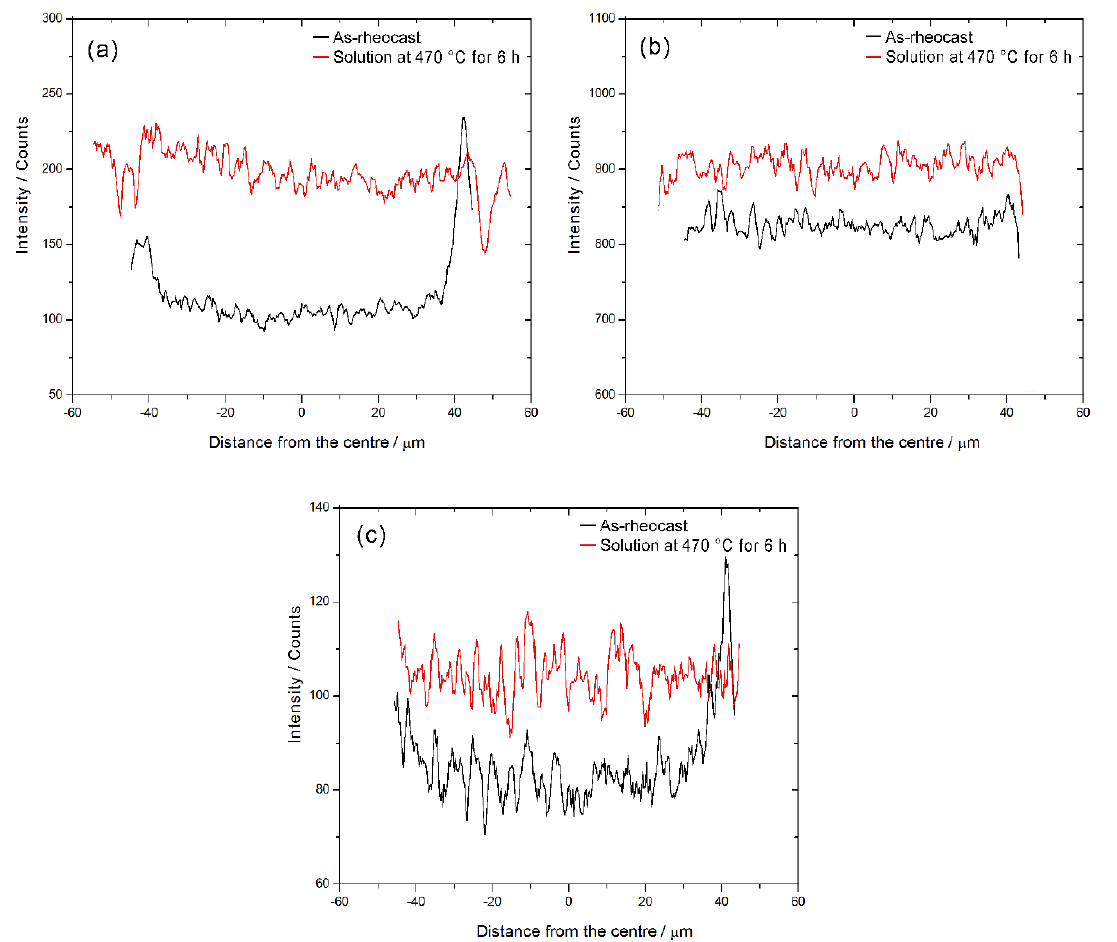
Figure 11. The distributions of ( a ) Cu, ( b ) Mg and ( c ) Zn across the width of α -Al crystals in as-rheocast condition and after 6 h of solution treatment at 470 °C.